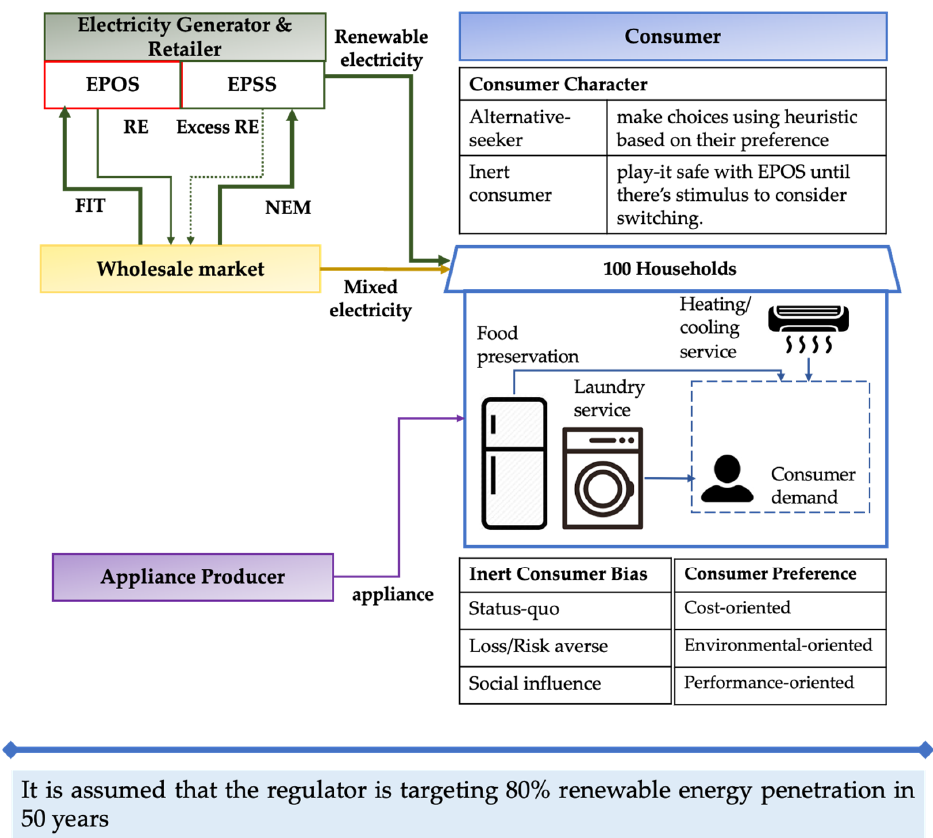
Figure 1. Market players’ interaction in the observed market. (NEM = Net metering; RE = Renewable Energy; FIT = Feed-in-Tariff)